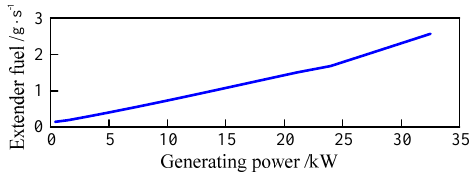
Figure 2. Extender output power vs. fuel consumption